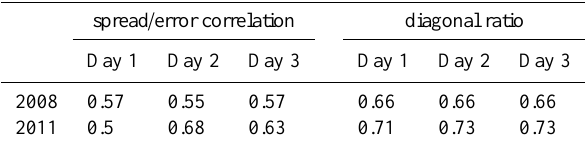
cases (Day 1, 2 and 3 interval are explained in Table 2